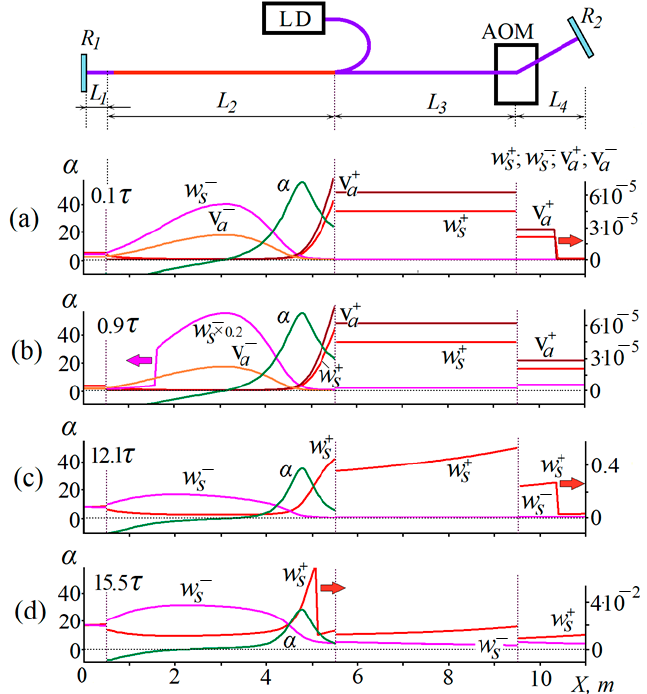
Figure 6. Formation of intensity peaks. Left scale: the gain coefficient α ; Right scale: the intensities of narrowband 𝑤 (cid:3046)(cid:2878) , 𝑤 (cid:3046)(cid:2879) and broadband 𝑣 (cid:3028)(cid:2878) , 𝑣 (cid:3028)(cid:2879) ASE waves. ( a ) propagation of the narrowband wave 𝑤 (cid:3046)(cid:2878) generated when the AOM is switched on; ( b ) amplification of the 𝑤 (cid:3046)(cid:2879) wave in the active medium; ( c ) the process of medium saturation after 12 passes of 𝑤 (cid:3046)(cid:2878) and 𝑤 (cid:3046)(cid:2879) waves; ( d ) the result of active medium high saturation with several intensity peaks.